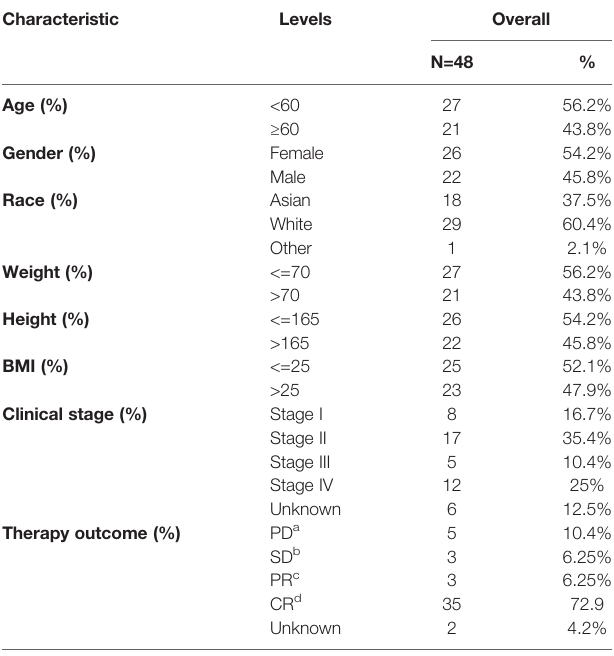
TABLE 1 | Baseline characteristics of DLBCL patients from the TCGA database. Characteristic